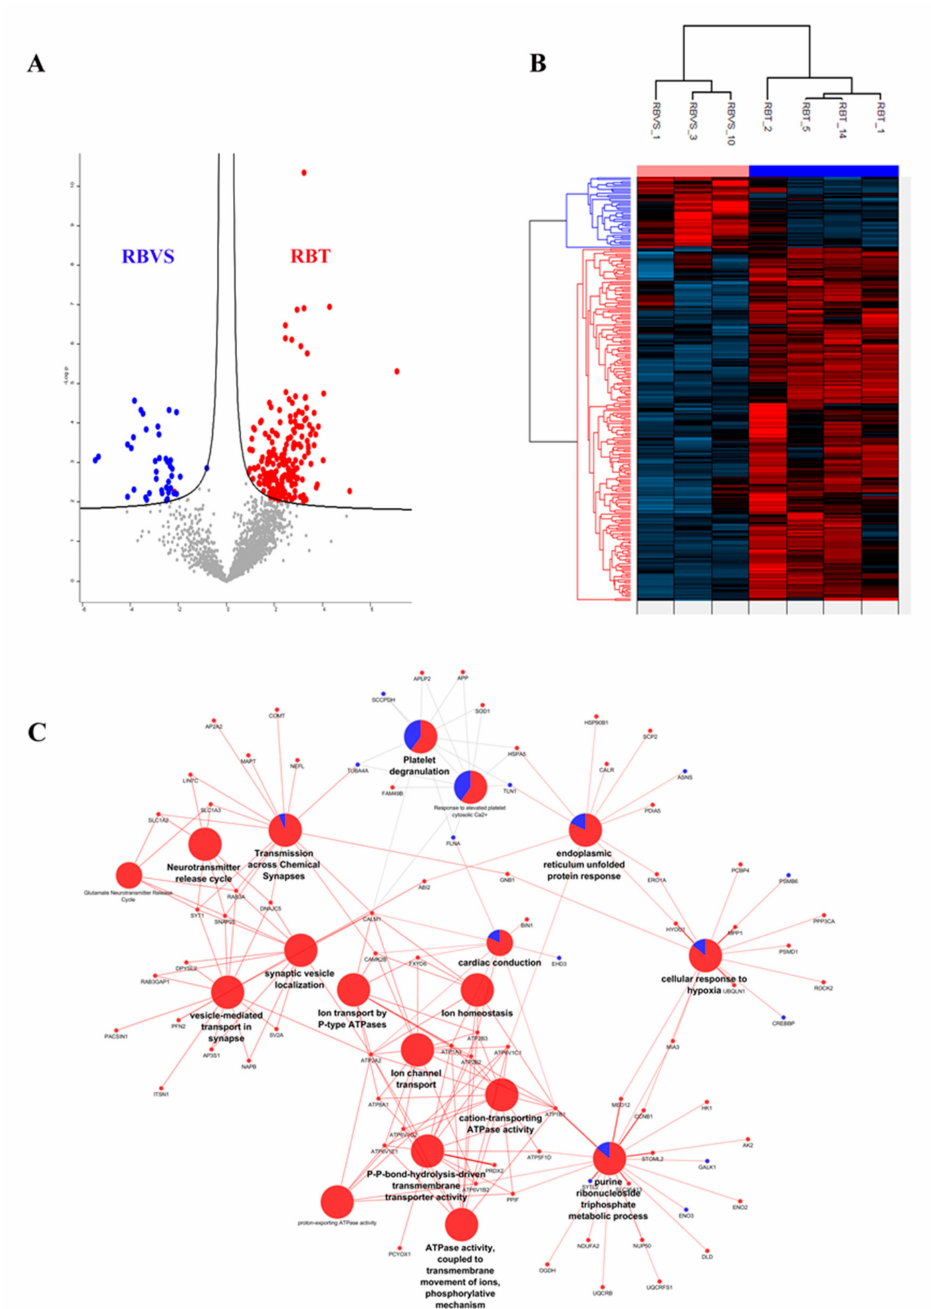
Figure 6. Differentially expressed proteins in RBT- and RBVS-derived exosomes and their network. ( A ) Volcano plot of differentially expressed proteins. Red dots depict proteins that display both large magnitude fold changes ( x -axis, to the right there are proteins upregulated in RBT samples), as well as high statistical significance ( − log10 of p value, y -axis). On the left side, dots representing RBVS proteins were reported, while on the right side, dots representing RBT proteins were showed. The black line shows where FDR = 0.05 and s0 = 0.1. Grey dots represent proteins for whom either fold change is < 2 (log2 = 1) or p > 0.05. Each data point is smoothed out by a suitable Gaussian kernel; ( B ) Unsupervised hierarchical-clustered heatmap of proteins identified by t -test. The amount of each protein in individual samples is represented by the color scheme, in which red and blue indicate high and low proteins expression, respectively. The average of three biological replicates is shown; ( C ) Network